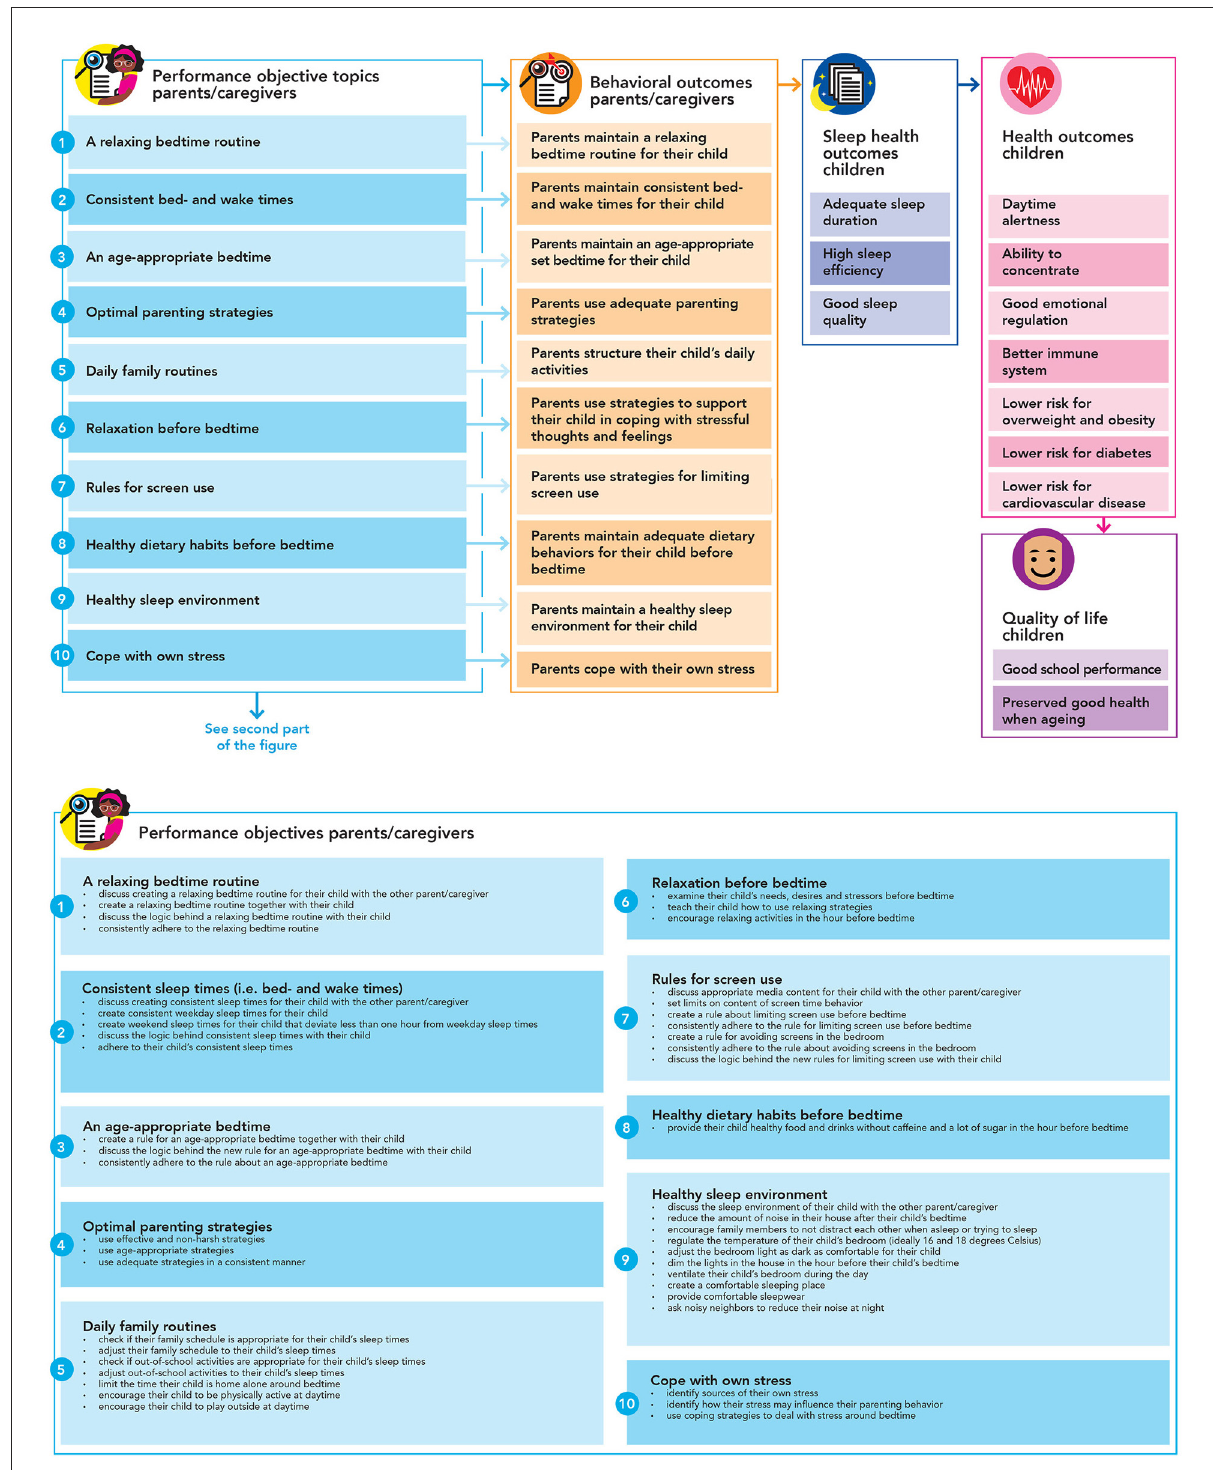
FIGURE5 Logic model of change for